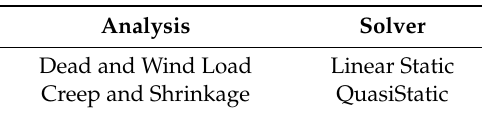
Table 6. Strand7